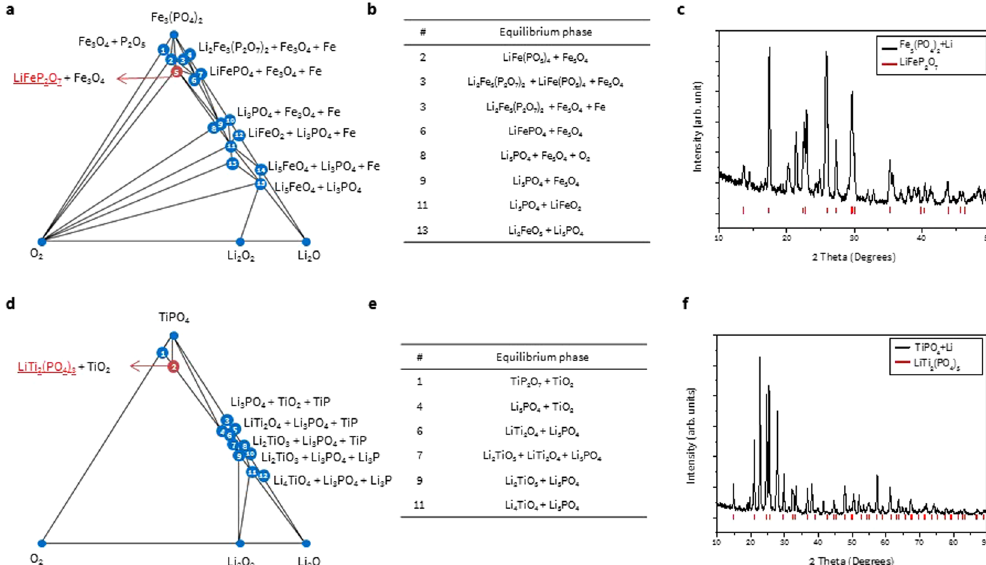
Figure 6. ( a , d ) Phase diagram, ( b , e ) equilibrium phase information, and ( c , f ) XRD pattern of Fe 3 (PO 4 ) 2 and TiPO 4 coating materials after reacting with Li residue (black) and peak information of the discovered phase. Blue and red circles in the phase diagram represent the stable phase and the stable phase confirmed from XRD analysis,